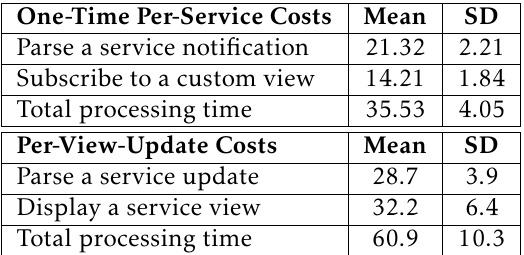
Table 5. Energy Consumed using ShareSens vs.